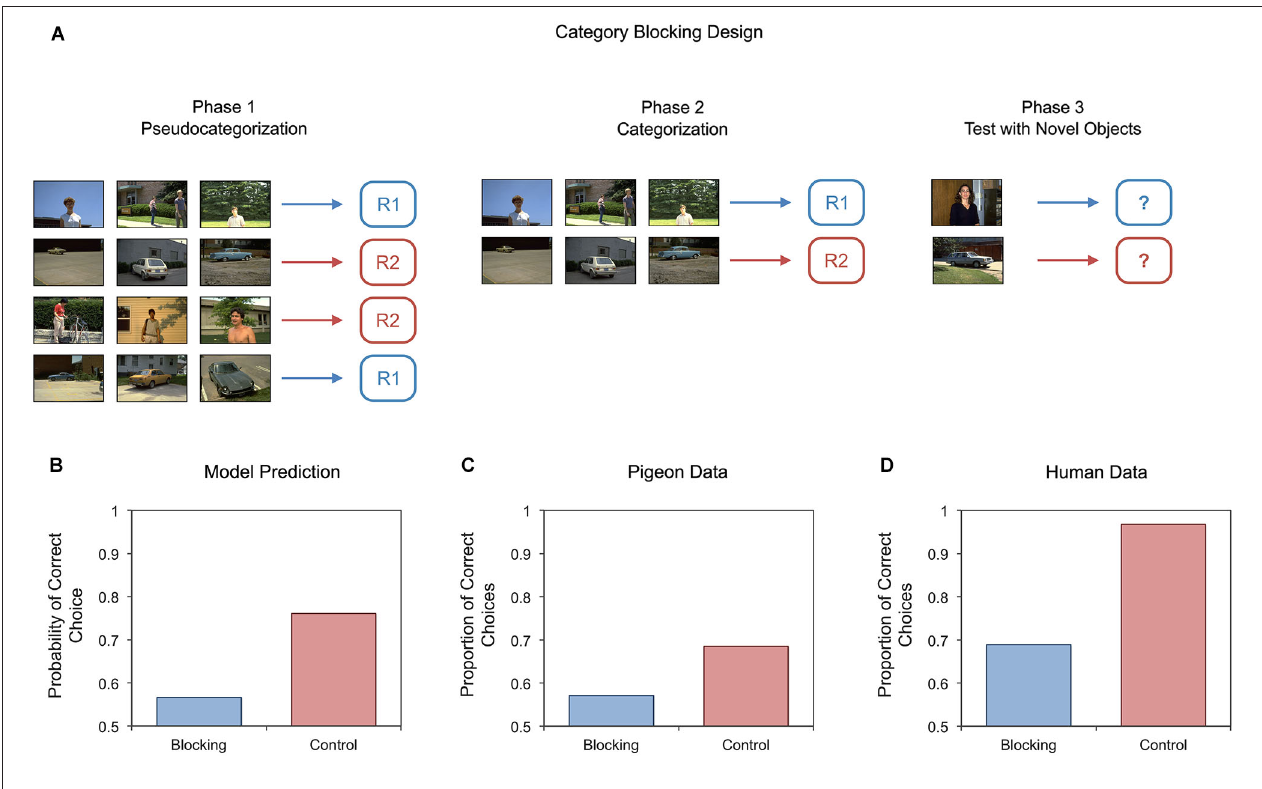
FIGURE 6 | Schematic diagram of an experiment on blocking of object category learning (A), together with our model’s predictions (B) and experimental results of studies with pigeons